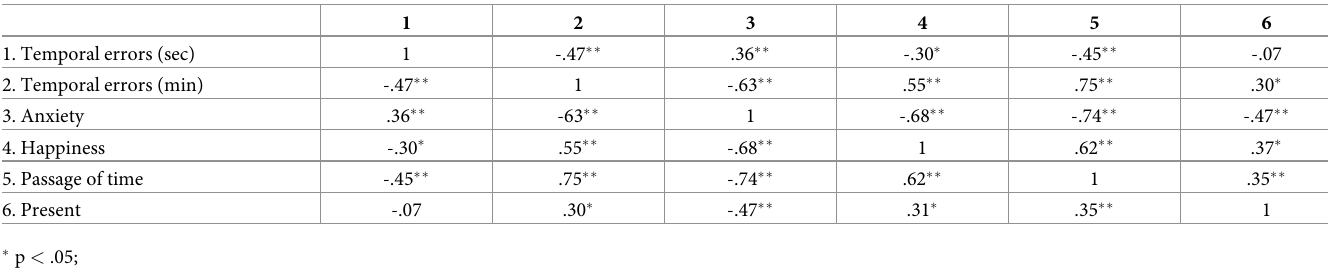
Table 2. Correlation matrix between the standardized temporal error in the seconds and the minutes range and the scores on the different scales.